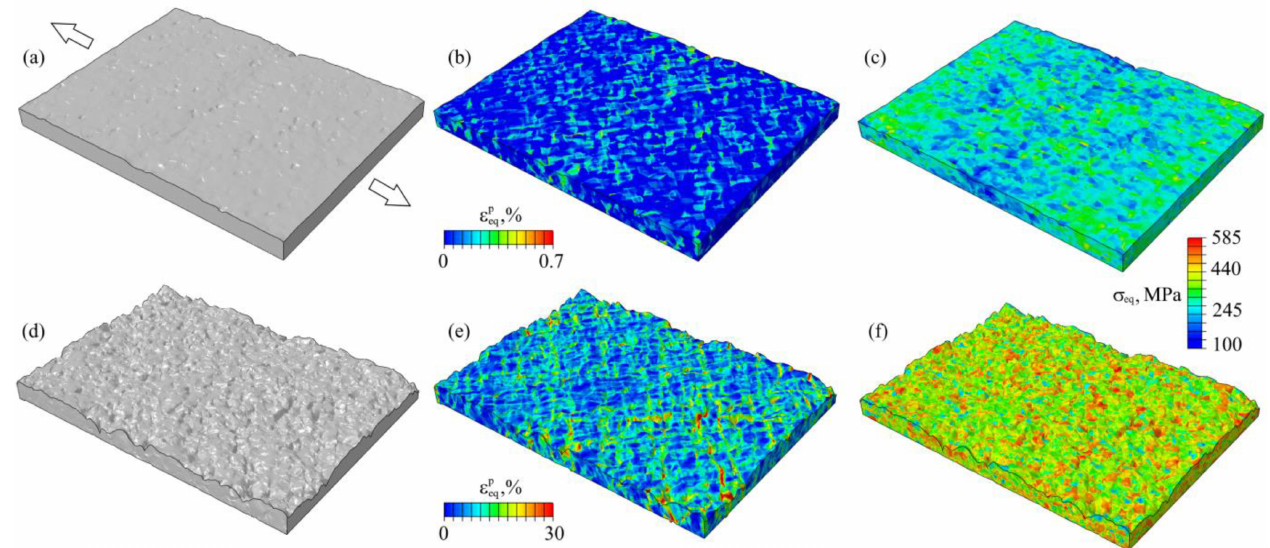
Figure 7. Calculated roughness patterns ( a , d ), and equivalent plastic strain ( b , e ) and stress fields ( c , f ) for 0.22% ( a – c ) and 5% tensile strains ( d – f ) (the vertical mesh displacements are scaled with a factor of